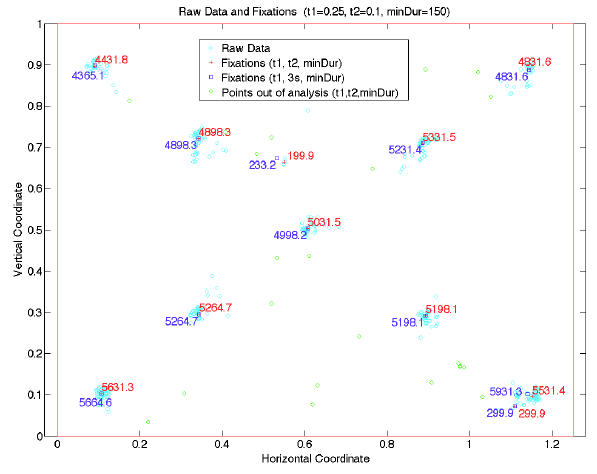
Eye tracking data and fixation’s centers after the execution of the fixation detection algorithm. Red points and red number labels correspond to the fixation’s centers and durations (ms) after performing t1, t2 and min duration criteria while the the blue points and the blue number labels correspond to the fixa- tion’s centers and durations after performing t1, 3s and min duration criteria.